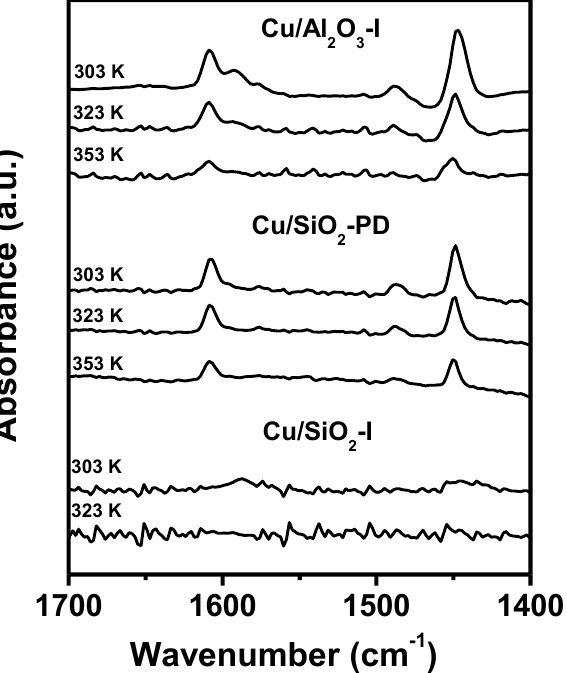
Figure 5. FTIR spectra of chemisorbed pyridine at different evacuation temperatures on the reduced Cu − -based samples.